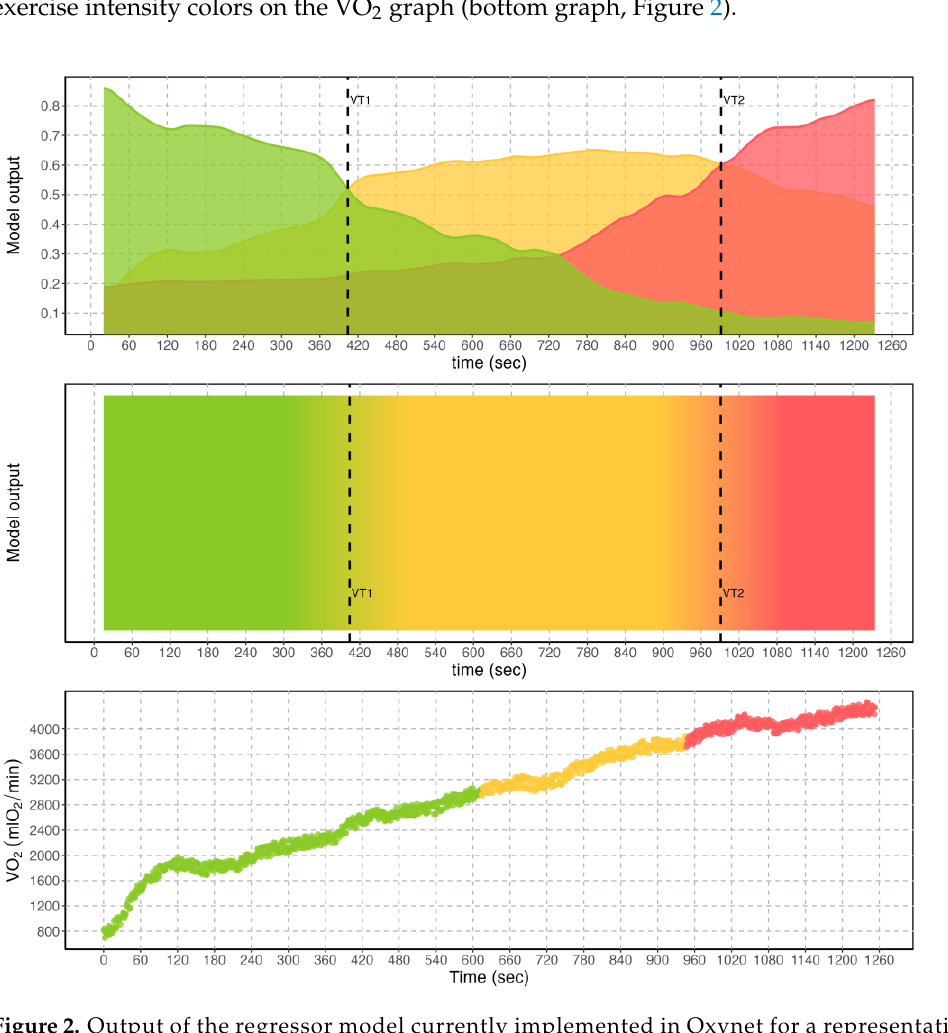
Figure 2. Output of the regressor model currently implemented in Oxynet for a representative individual. ( Top ): output neurons of the convolutional neural network, corresponding to the three